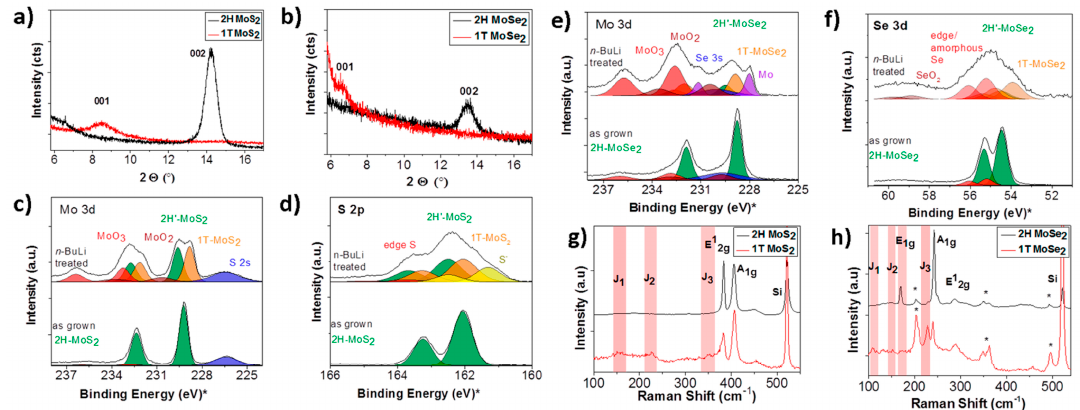
Figure 5. XRD pattern of: 1T and 2H MoS 2 ( a ); and MoSe 2 ( b ). XPS results for: Mo 3d ( c ); and S 2p ( d ) peaks of pure 2H and Li-intercalated MoS 2 . XPS results for: Mo 3d ( e ); and S 2p ( f ) peaks of pure 2H and Li-intercalated MoSe 2 . Raman spectra of: 1T and 2H MoS 2 ( g ); and MoSe 2 ( h ). Reprinted (adapted) with permission from [28]. Copyright (2016) American Chemical Society: Washington, DC, USA.